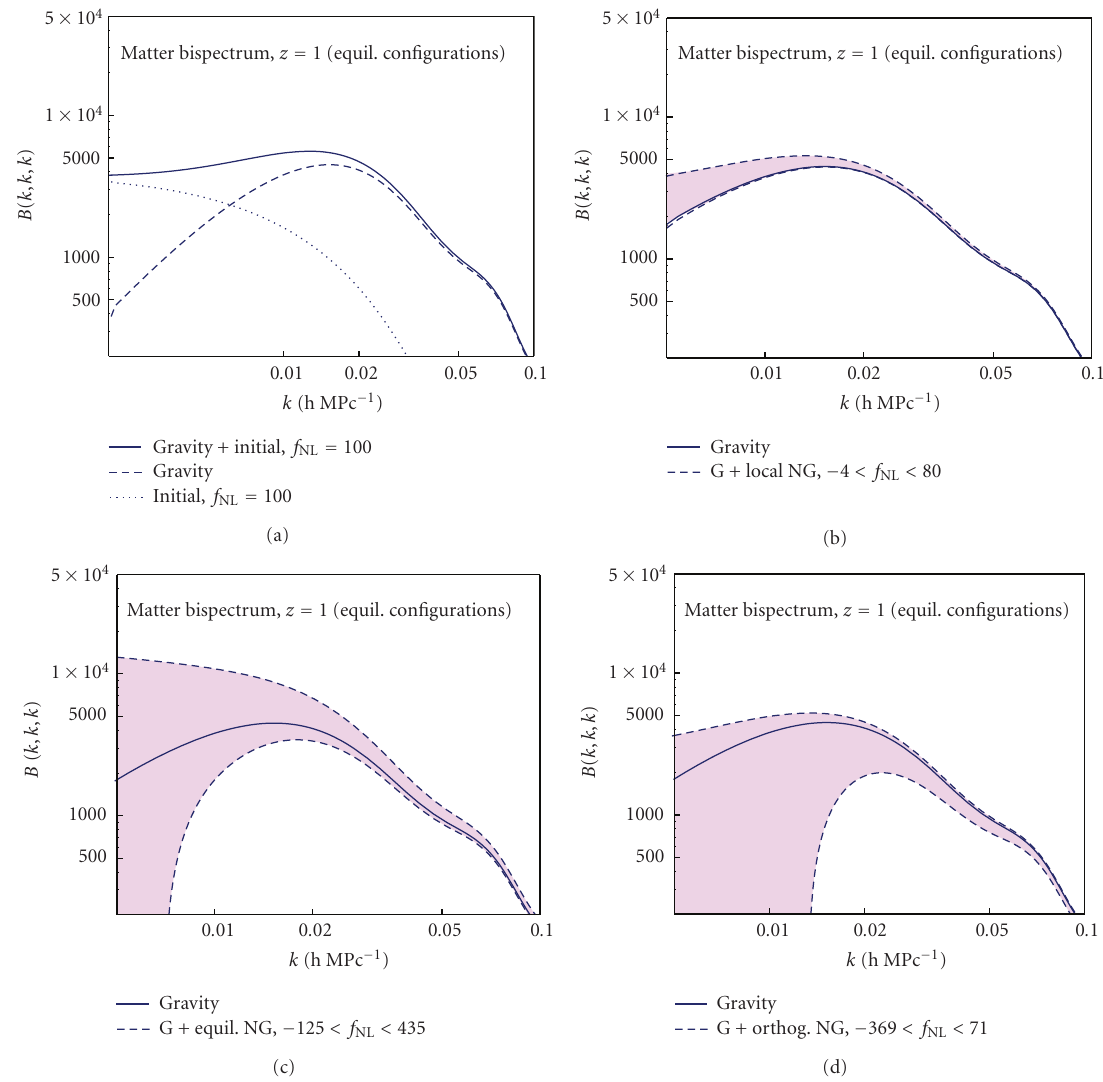
Figure 15: E ff ect of the primordial component for di ff erent non-Gaussian models on the equilateral configurations of matter bispectrum, B ( k , k , k ), at redshift z = 1, as a function of scale, at tree level in PT. In (a) the continuous line shows the initial component B 0 ( dotted line ), ( dashed line ) and their sum ( continuous line ). For equilateral configurations the initial component the gravity-induced component, B tree G coincides for the local, equilateral, and orthogonal models while it vanishes in the folded model. In (b), (c), and (d), continuous lines show the gravity component alone while dashed lines show the tree-level bispectrum including the primordial component for the local (b), equilateral (c), and orthogonal (d) models assuming the values of f NL corresponding to the 95% C.L. limits as determined by Smith et al. [68] and Senatore et al. [18] from WMAP observations. The shaded area indicates the currently allowed